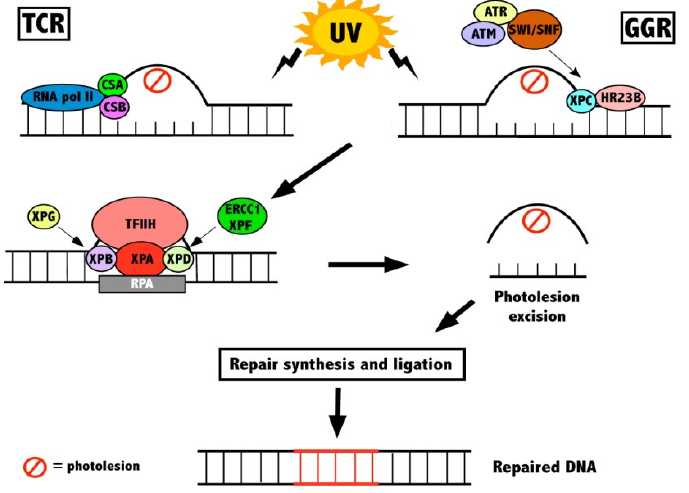
Figure 1. The mechanisms of NER following UV radiation. Photolesions are recognised by both TCR and GGR, both of which have specific recognition factors involved.